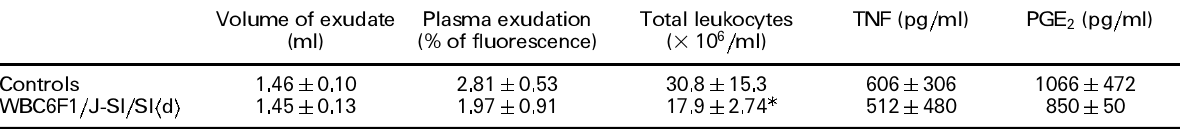
Table 4. Effect of mast-cell de® ciency on carrageenan-induced in¯ ammation in the mouse air